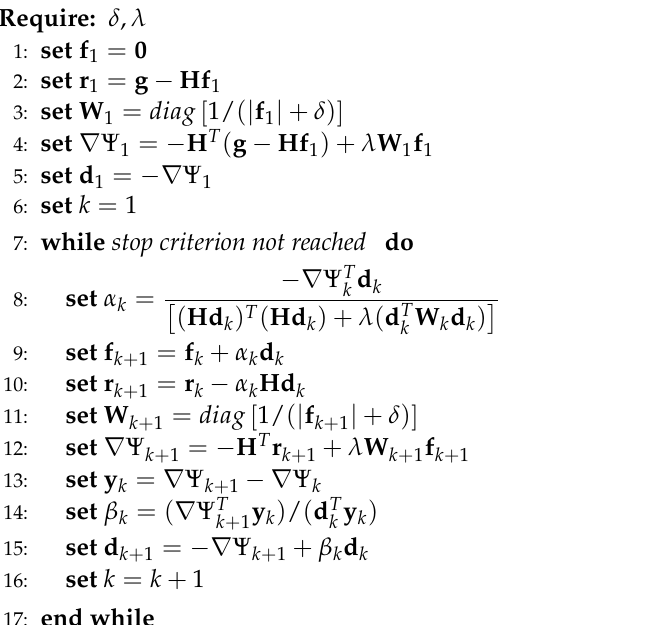
Algorithm 4 Nonlinear Conjugate Gradient (NLCG)